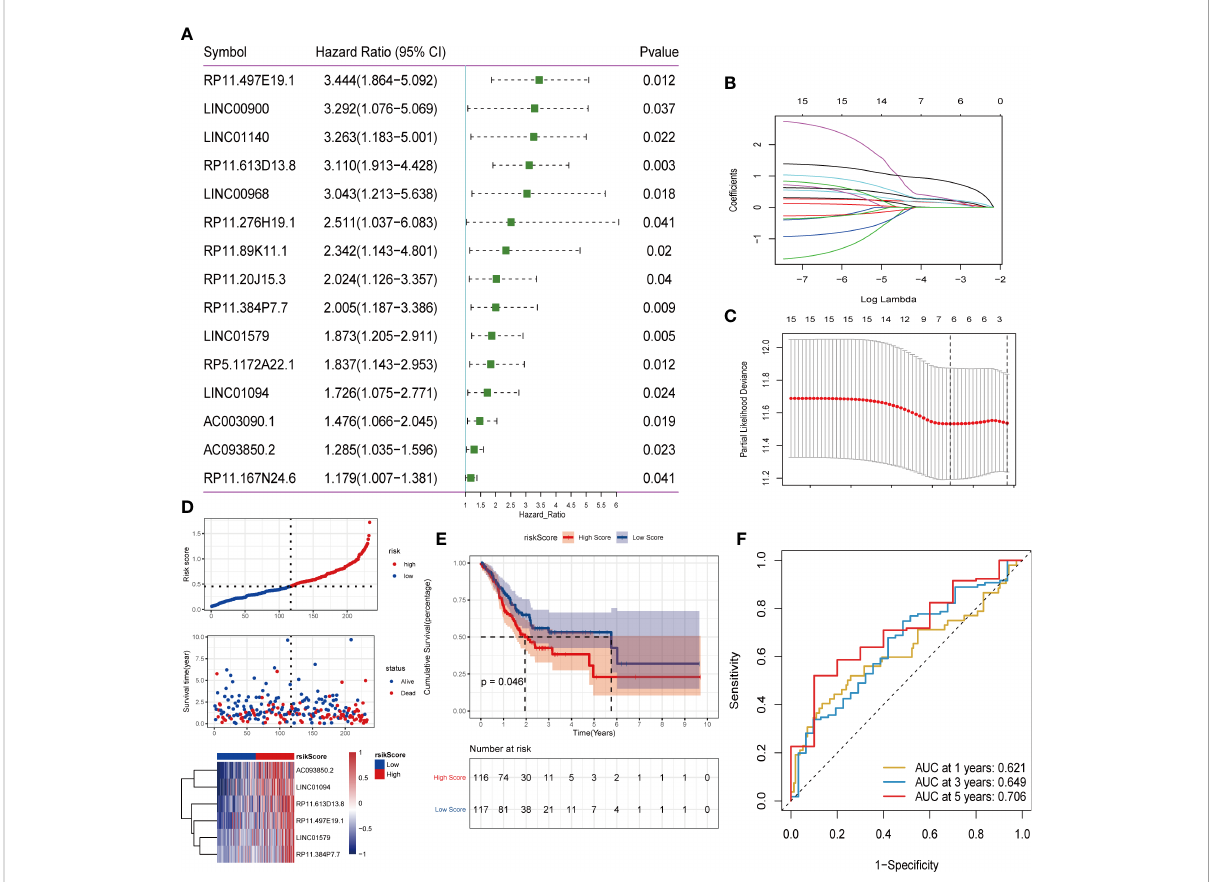
FIGURE 6 Screening of lncRNA and construction of risk model. (A) One-factor cox screening; (B) Change trajectory of each independent variable, the horizontal axis represents the log value of the independent variable lambda, and the vertical axis represents the coef fi cient of the independent variable; (C) Con fi dence interval under each lambda; (D) Risk Distribution of scores; (E) Survival curve; (F) ROC